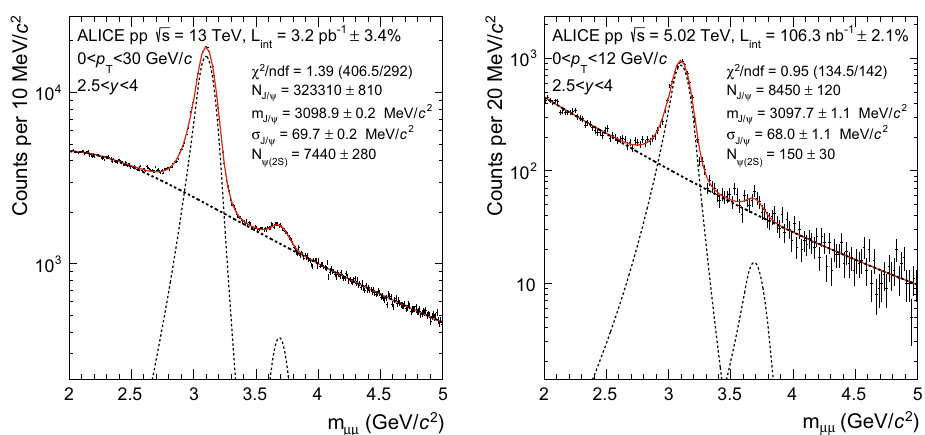
√ s = 13 TeV ( left ) and 5 . 02 TeV ( right ). Dashed